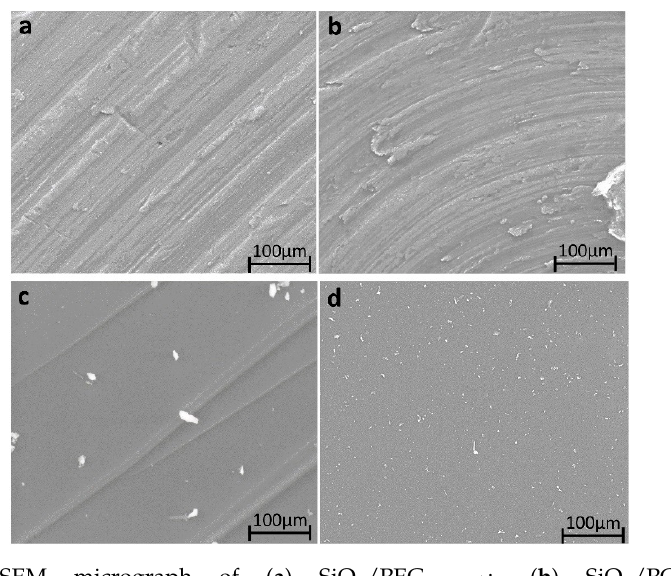
Figure 2. SEM micrograph of ( a ) SiO 2 /PEG 50 wt % ; ( b ) SiO 2 /PCL 50 wt % ; ( c ) SiO 2 /PEG 50 wt % /CGA 20 wt % ; ( d ) SiO 2 /PCL 50 wt % /CGA 20 wt %.